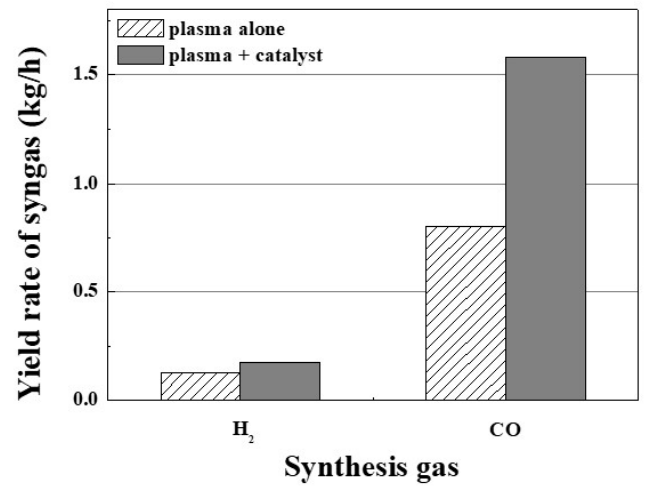
Figure 7. Syngas yield rates obtained using the hybrid system. 2